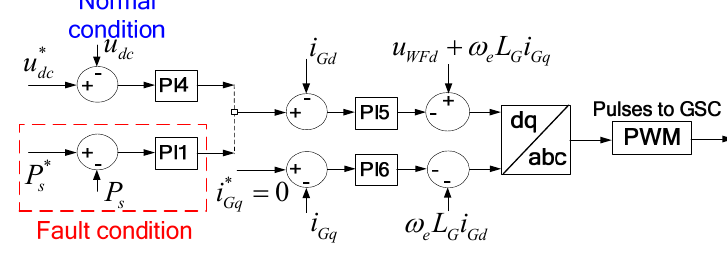
Figure 11. Control diagram of GSC under fault